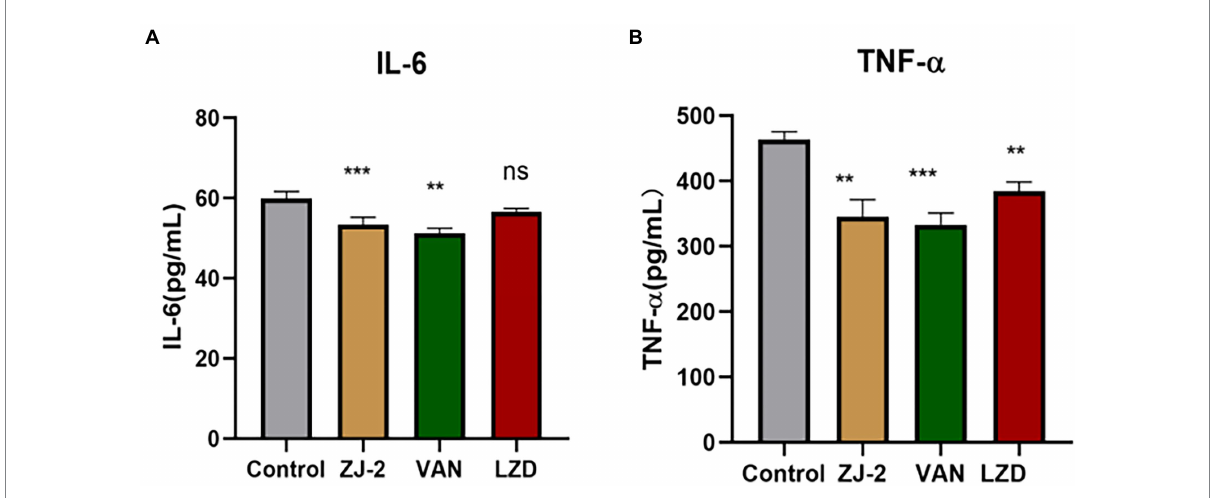
FIGURE 9 The IL-6 (A) and TNF- α (B) level in the serum at 12 h after E. faecium E3101 inoculation ( n = 4). Values represent means ±SD; *** p < 0.01, ** p <